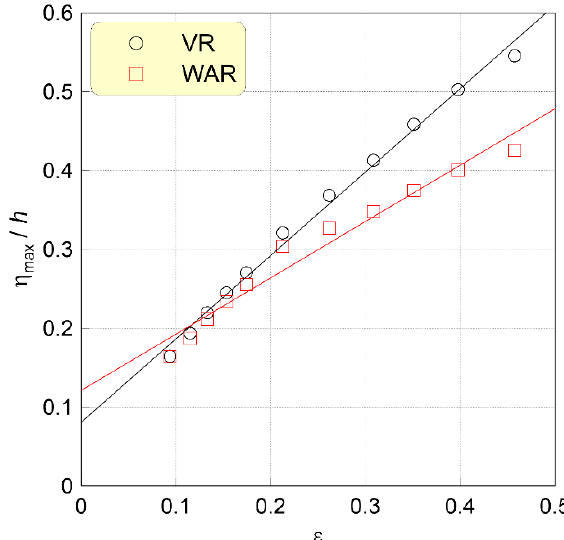
Figure 4. Distributions of maximum water surface elevations due to ε at the front of the vertical wall — comparison between VR and WAR.